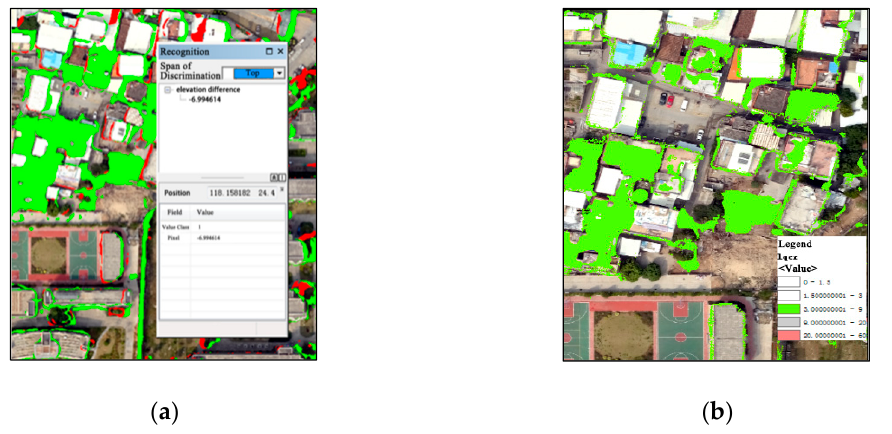
Figure 5. ( a ) Patches elevation query and ( b ) patches elevation drawing.